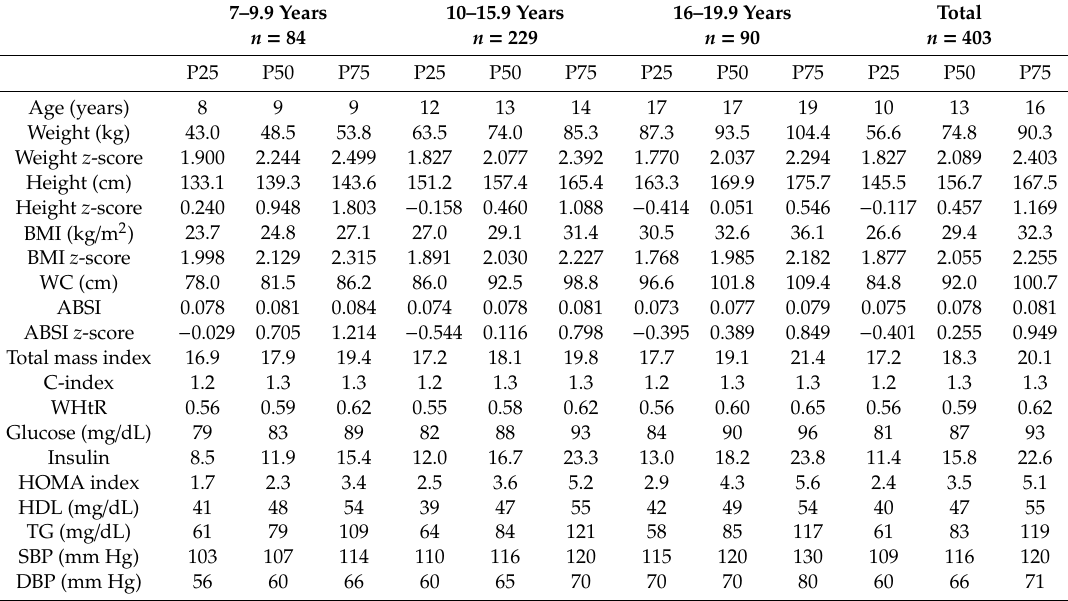
Table 1. Characteristics of the recruited subjects according to age